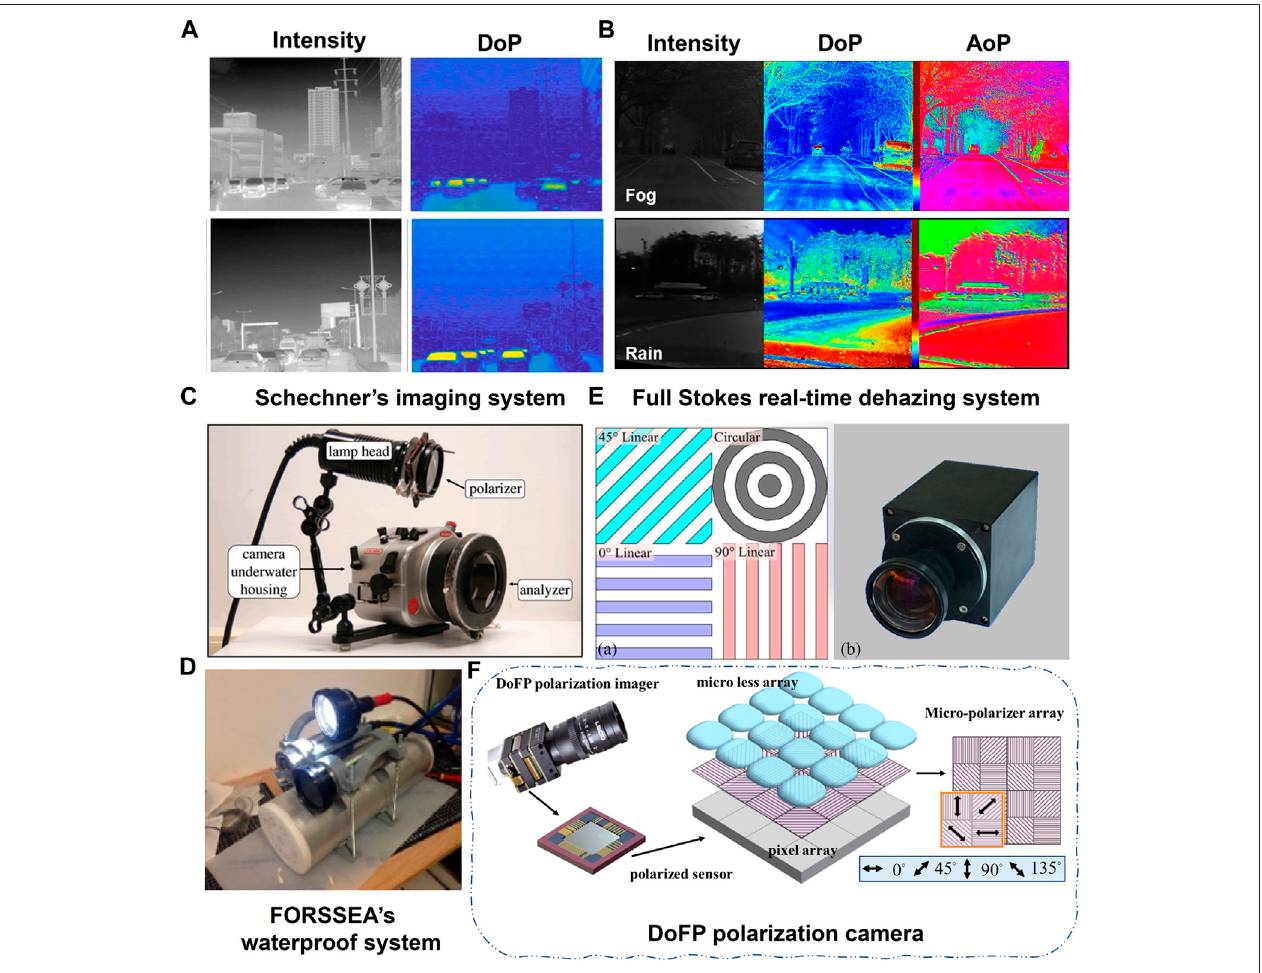
FIGURE 15 | (A) Images by LWI-DoFP camera (reprint from Elsevier: ISPRS Journal of Photogrammetry and Remote Sensing [146], copyright 2021). (B) Polarimetric imaging in the fi eld of self-driving [153]. Different systems of polarimetric underwater imaging were developed for realistic applications. (C) Schechner ’